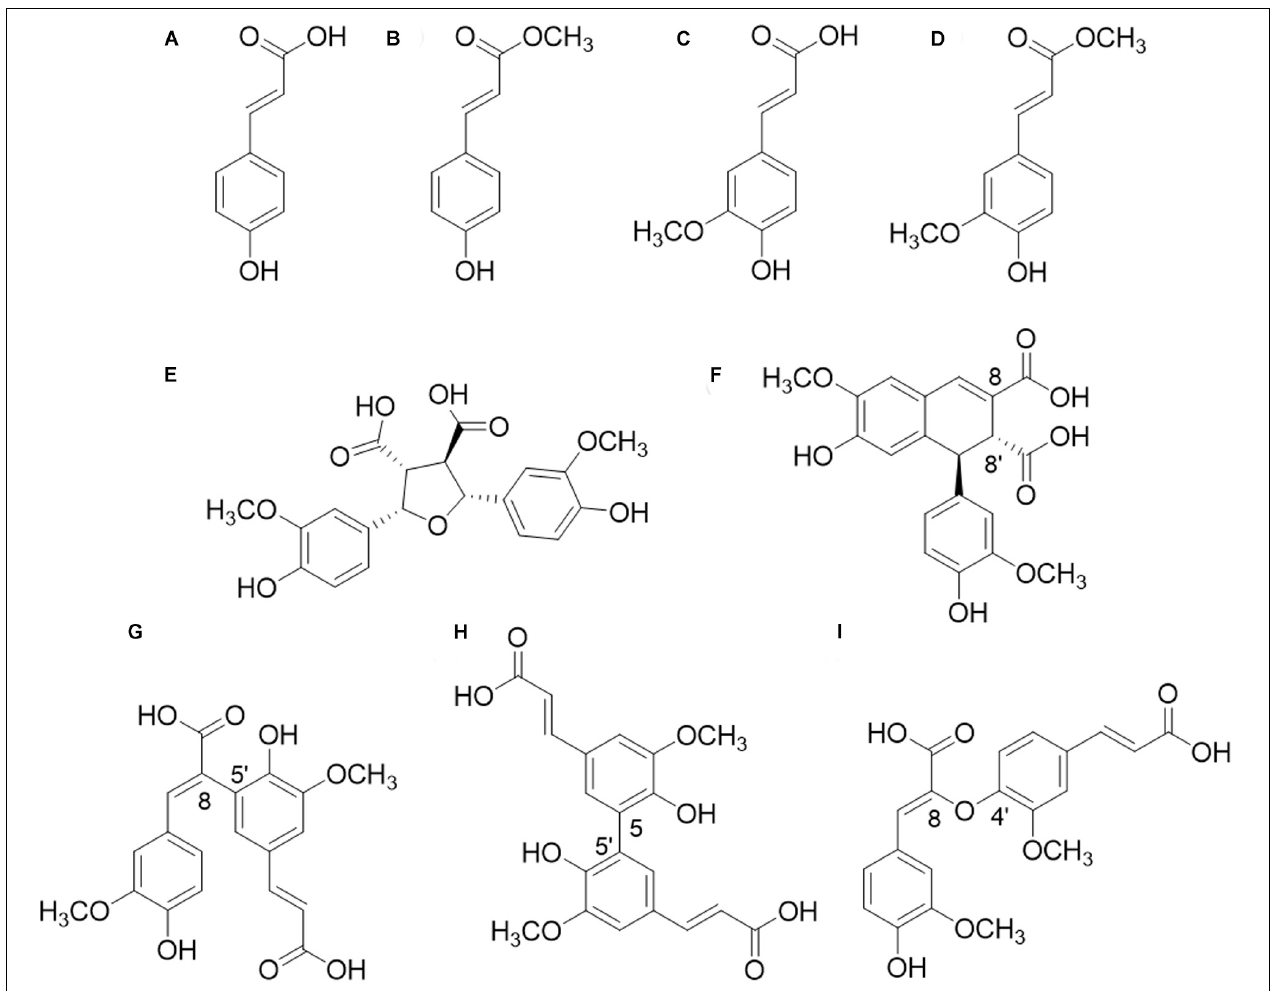
FIGURE 1 | Structures of hydroxycinnamic acids (HCAs). (A) p-coumaric acid (pCA); (B) methyl p-coumarate; (C) ferulic acid (FA); (D) methyl ferulate; (E) 8-8 (cid:48) -(furan)-diferulic acid (8-8 (cid:48) -diFA); (F) 8-8 (cid:48) -(aryl)-diFA; (G) 8-5 (cid:48) -diFA; (H) 5-5 (cid:48) -diFA; (I) 8-O-4 (cid:48)